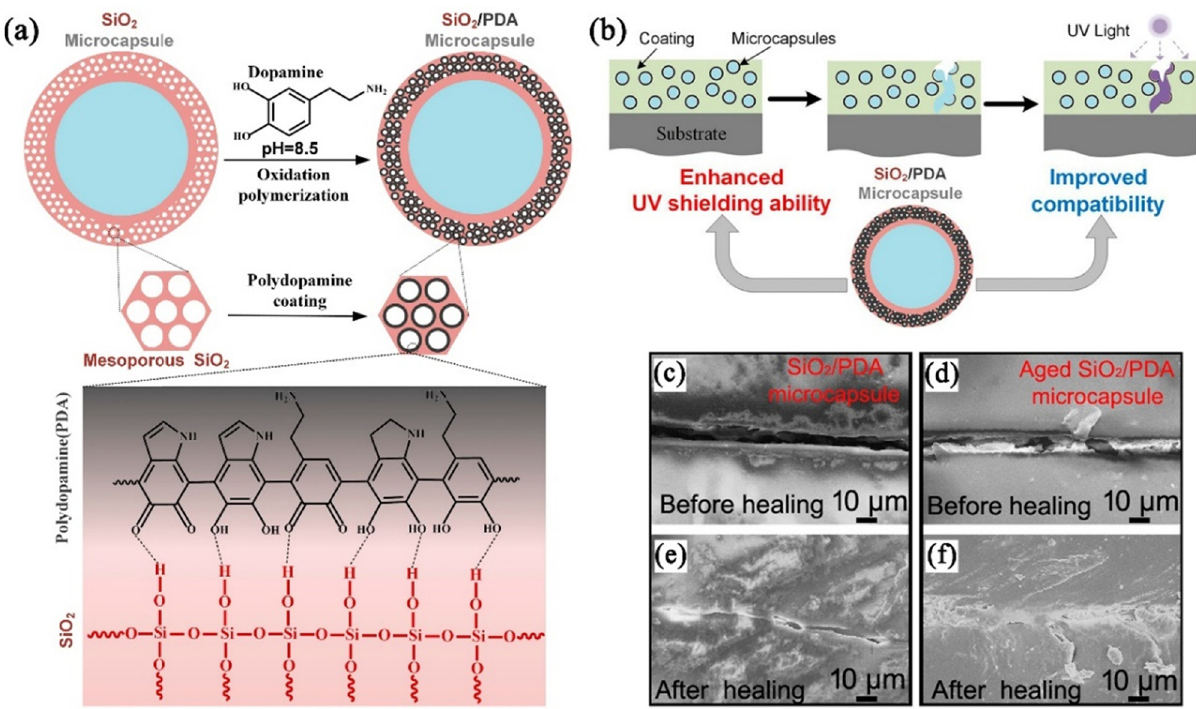
Figure 22: ( a ) Preparation process of SiO 2 /PDA microcapsules, ( b ) principle of UV shielding and compatibility of SiO 2 /PDA microcapsule - reinforced coatings, ( c and d ) self - healing e ff ect of SiO 2 /PDA microcapsule coating before UV irradiation aging, ( e and f ) self - healing e ff ect after UV irradiation aging [ 130 ] ; Copyright: 2022 with permission from Elsevier Science